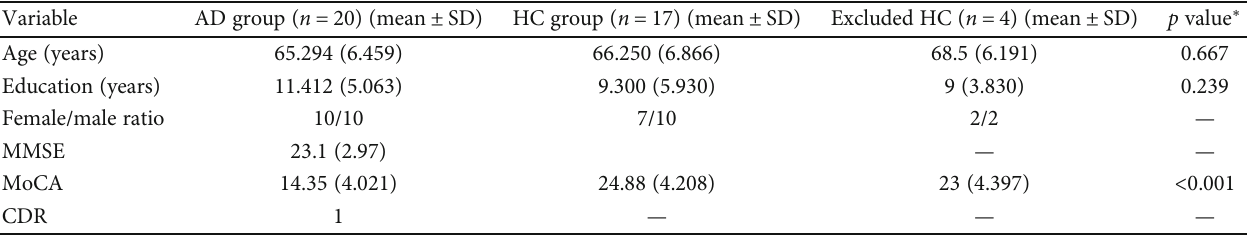
Table 2: Demographic features of all participants. Age and education show no signi fi cant di ff erences between groups, but a signi fi cant di ff erence was found in MoCA.